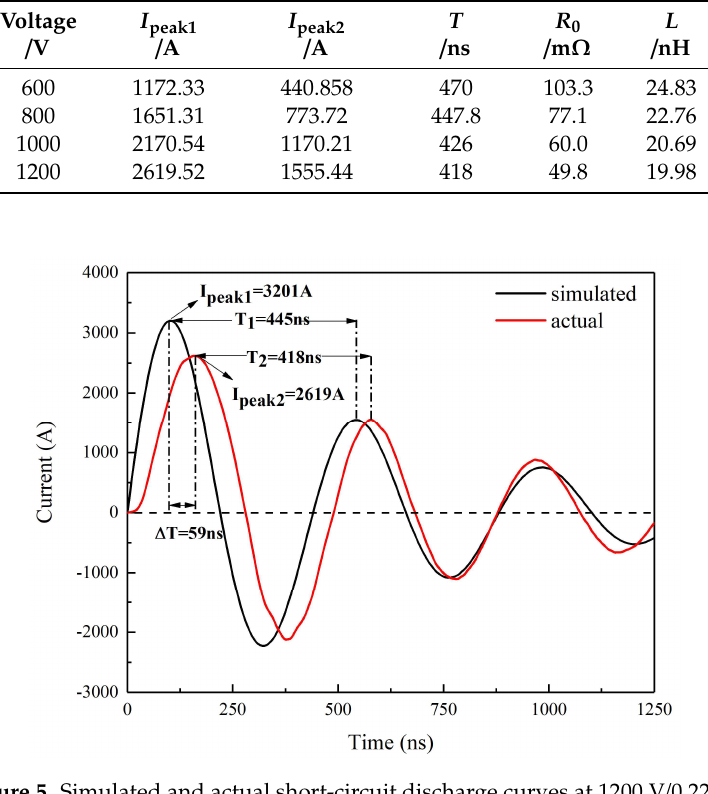
Figure 5. Simulated and actual short-circuit discharge curves at 1200 V/0.22 μF.